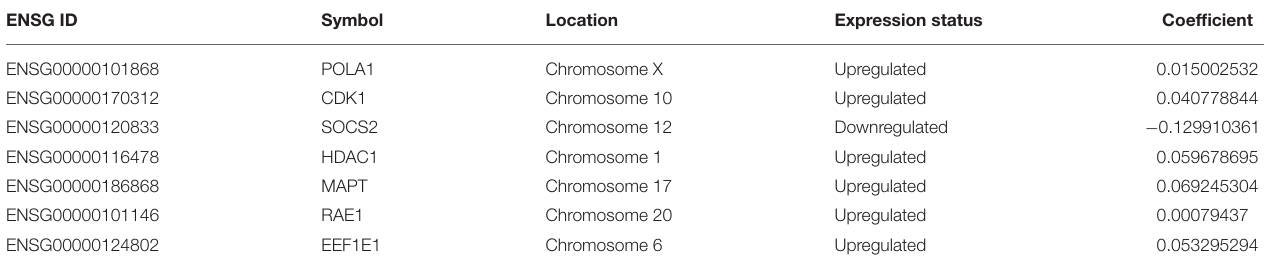
TABLE 2 | The 7 genes associated with the risk model in